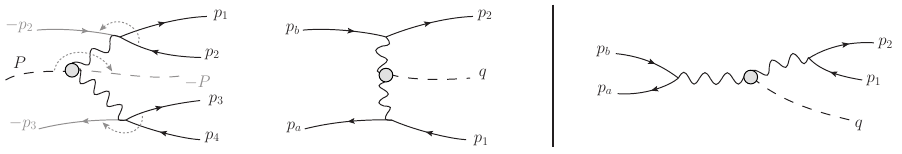
Figure 2. Left block shows the choice for crossing relations from direct double-Dalitz terms (left) to the e + e − → e + e − P t -channel ones (center). The right block is the s-channel contribution to the latter process that would be crossing-related to the double-Dalitz exchange